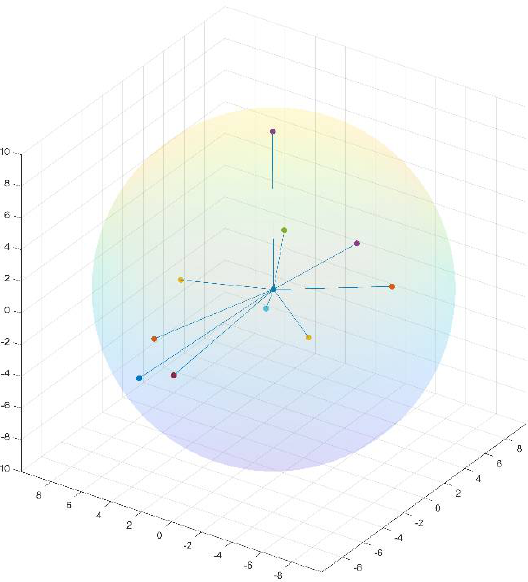
Figure 7. Structure neighbors of a given amino acid AA i in the 3D space. AA i is the center of the sphere.